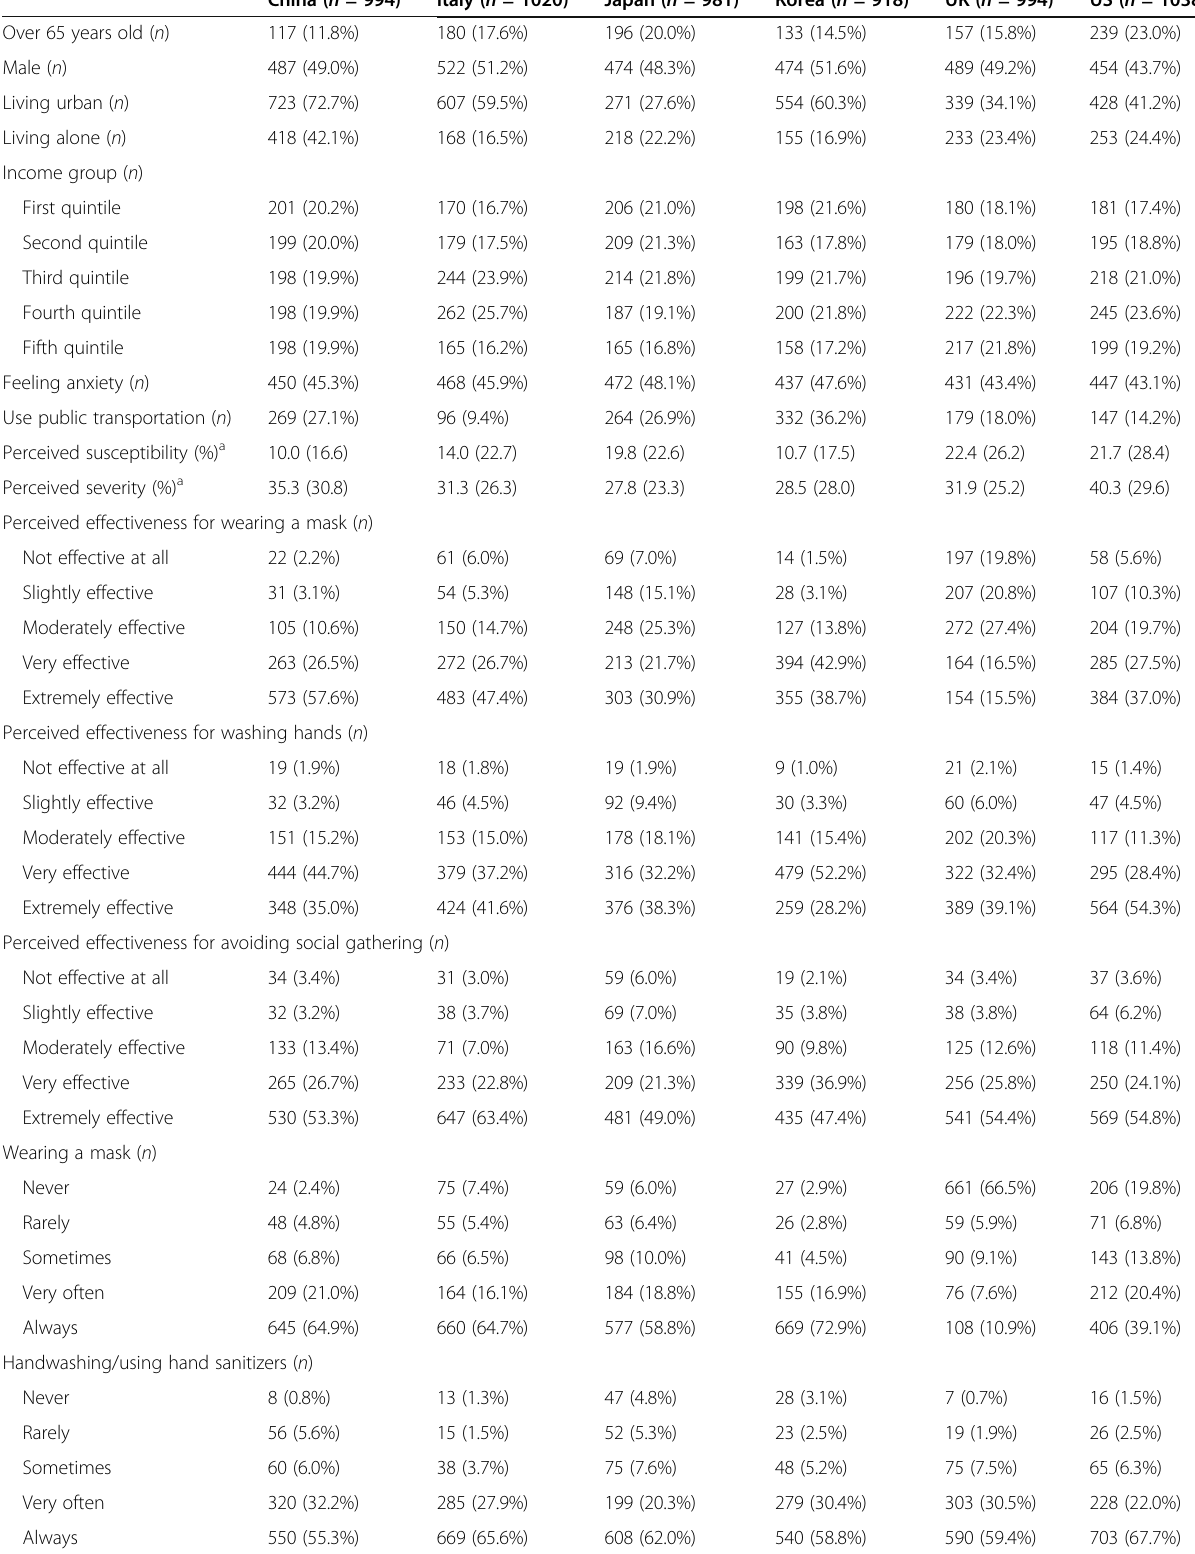
Table 2 Public perception and personal characteristics of participants by six